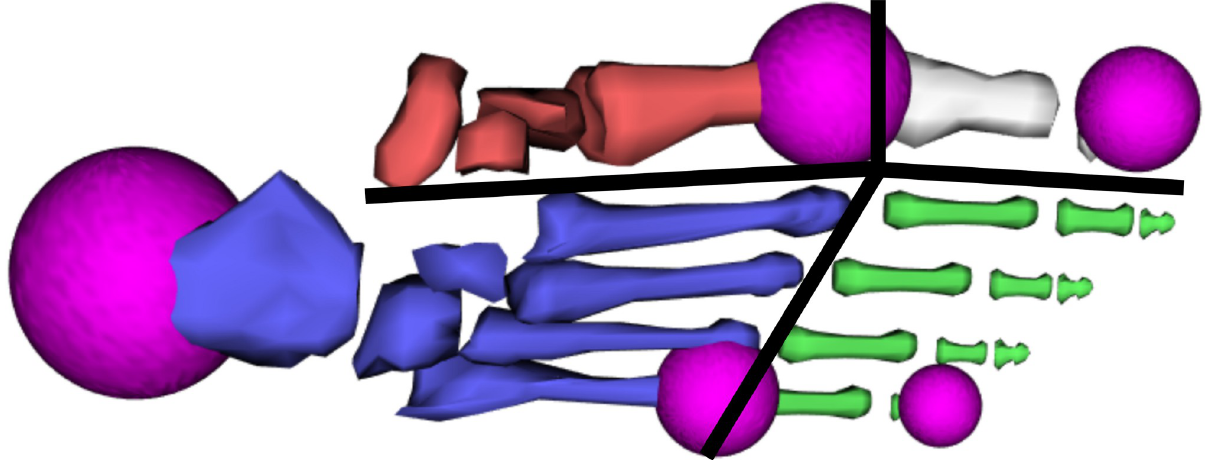
Fig 3. Foot model segments and contact geometries. Foot model developed for the gait simulations with four distinct segments: medial midfoot (red), medial forefoot (white), lateral midfoot (blue), and lateral forefoot (green). Five spheres used for generating contact forces between the foot and ground plane (pink) and the joints between foot segments (black lines) are also